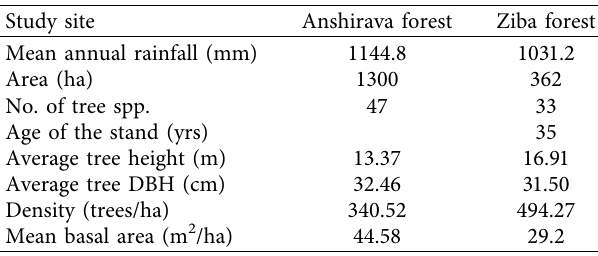
Table 1: Stand characteristics of the studied forests (source: Author